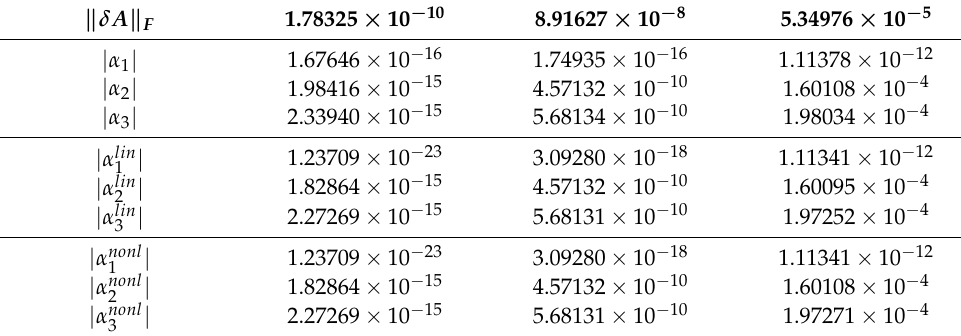
Table 2. Approximation of the diagonal elements of matrix W